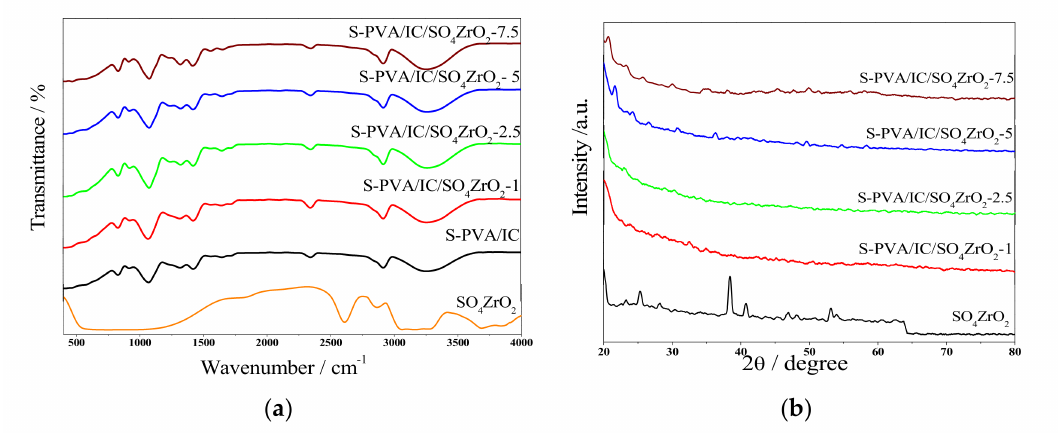
Figure 1. ( a ) FTIR spectra and ( b ) XRD patterns of SO 4 ZrO 2 and S-PVA/IC/SO 4 ZrO 2